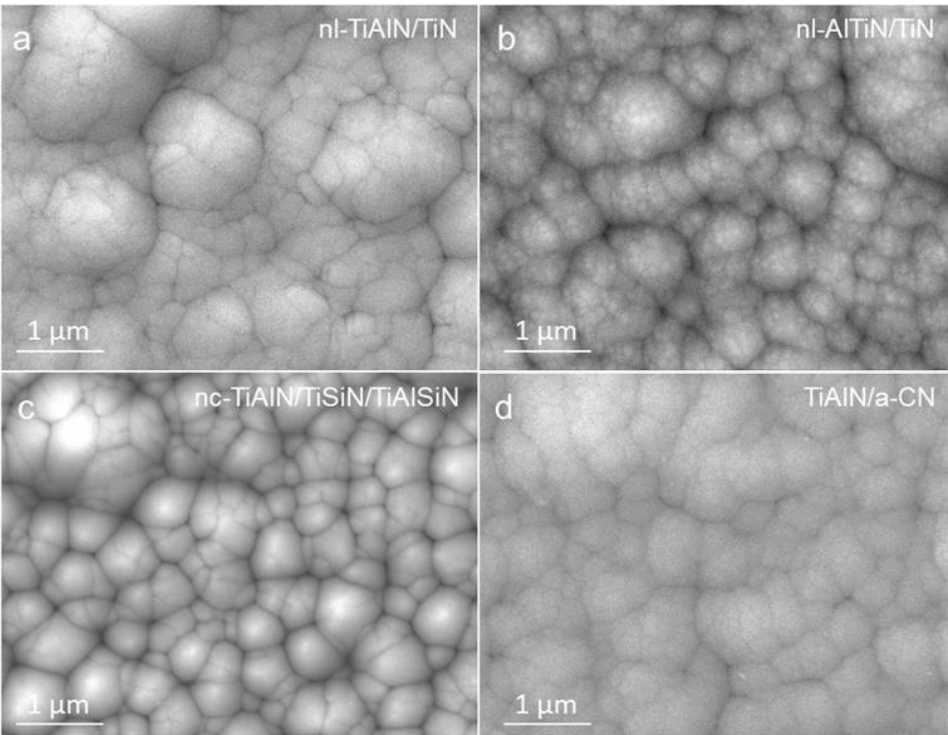
Figure 26. Surface morphology of four different hard coatings: nl-TiAlN/TiN ( a ), nl-AlTiN/TiN ( b ), ns-TiAlN/TiSiN/TiAlSiN ( c ) and TiAlN/a-CN ( d ). They were deposited on D2 tool steel substrates in the CC9 system using 1-fold rotation.